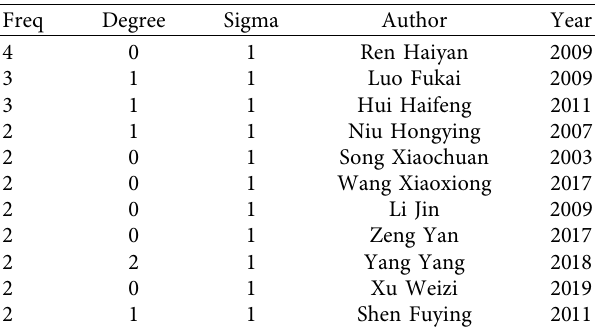
Figure 1: Publications of Robinson Crusoe with the title indicating the hero’s drifting story. Table 1: Active authors of Robinson Crusoe